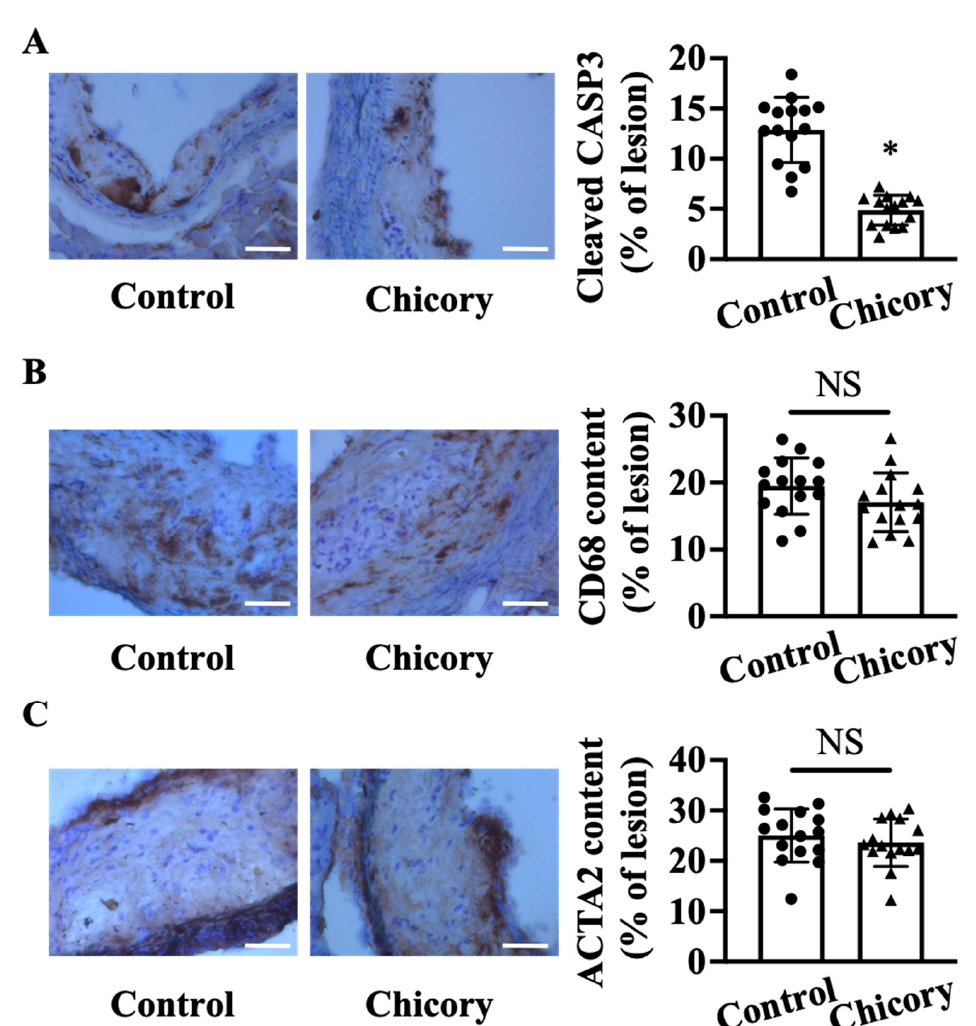
Figure 2. Brussels chicory consumption reduces plaque apoptosis without affecting the content of macrophages and smooth muscle cells in aortic root plaques in Apoe − / − mice. ( A – C ) Representative immunohistochemistry images of cleaved CASP3 (( A ), left panel), CD68 (( B ), left panel), and ACTA2 (( C ), left panel) in aortic root sections and quantification of the percentage of cleaved CASP3 (( A ), right panel), CD68 (( B ), right panel), and ACTA2 positive cells (( C ), right panel) in aortic root plaques. Scale bar, 100 µ m. Data are presented as means ± SD. n = 15. * Significantly different from the control group ( p < 0.05). Scale bars: 100 µ m. ACTA2, actin α 2; Apoe, apolipoprotein E; Chicory, Brussels chicory; NS, nonsignificant ( p ≥ 0.05).